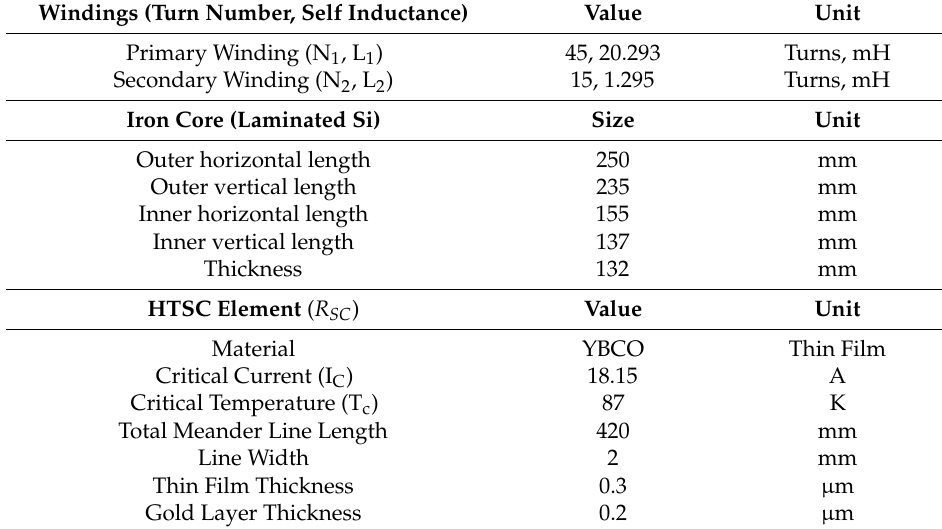
Table 1. Specifications of bridge type SFCL with a single HTSC element using